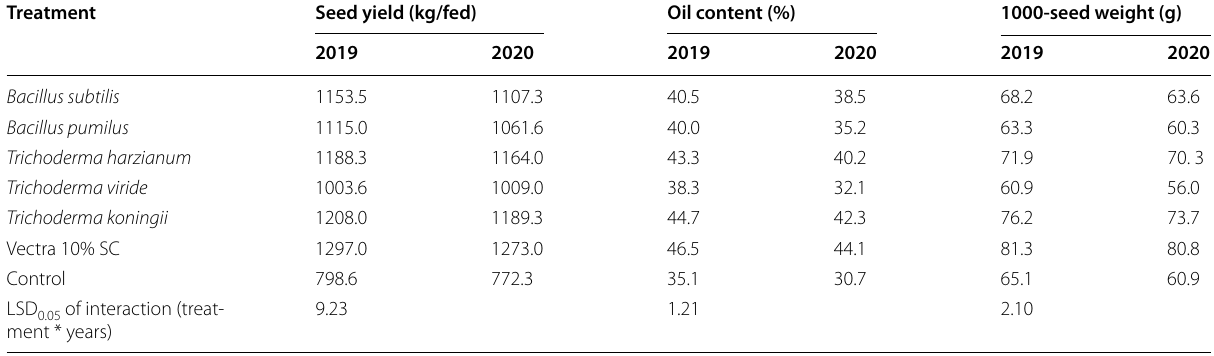
Table 5 Effects of certain treatments on yield components of sunflower plants against powdery mildew disease of sunflower pants